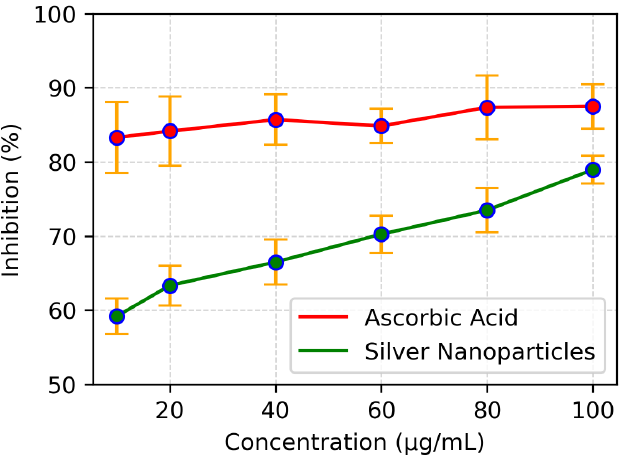
Figure 8. Comparisons of absorbance values of different concentrations of ascorbic acid and AgNP in the DPPH assay.